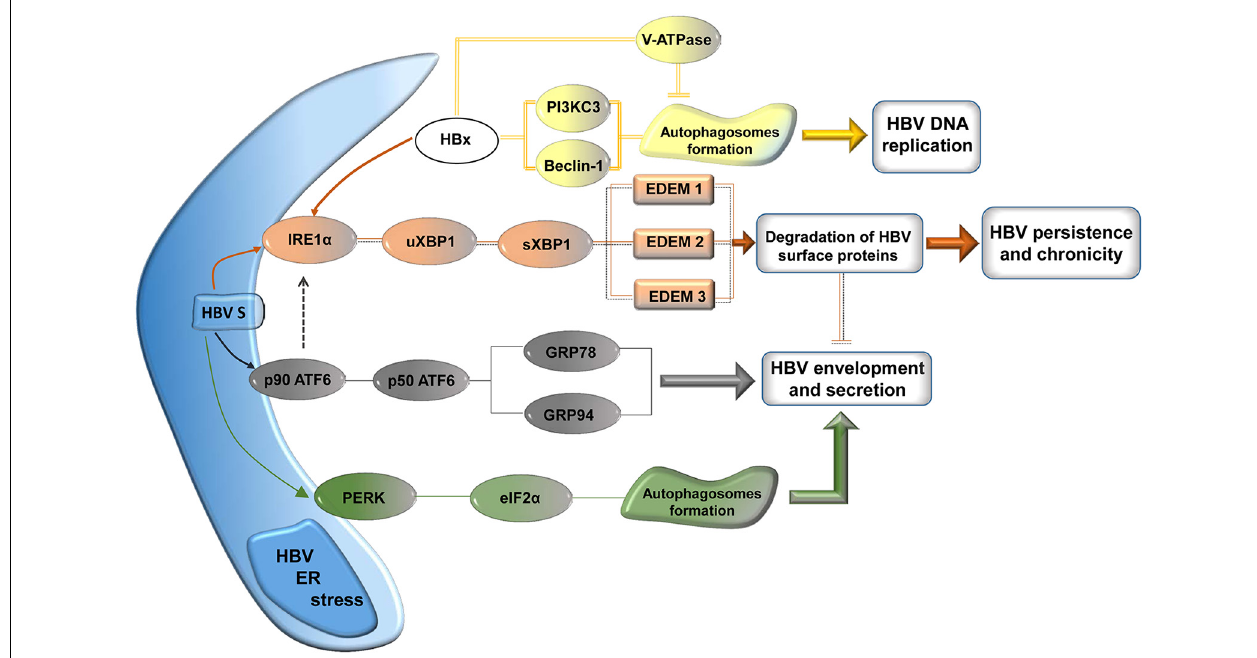
FIGURE 3 | Signaling pathways modulated by HBV for its own benefit. The surface proteins activate the UPR leading to autophagy, involved in nucleocapsid envelopment and virus particle secretion. Activation of the IRE1 pathways results in up-regulation of the EDEM family of proteins, which reduces the load of viral surface proteins,